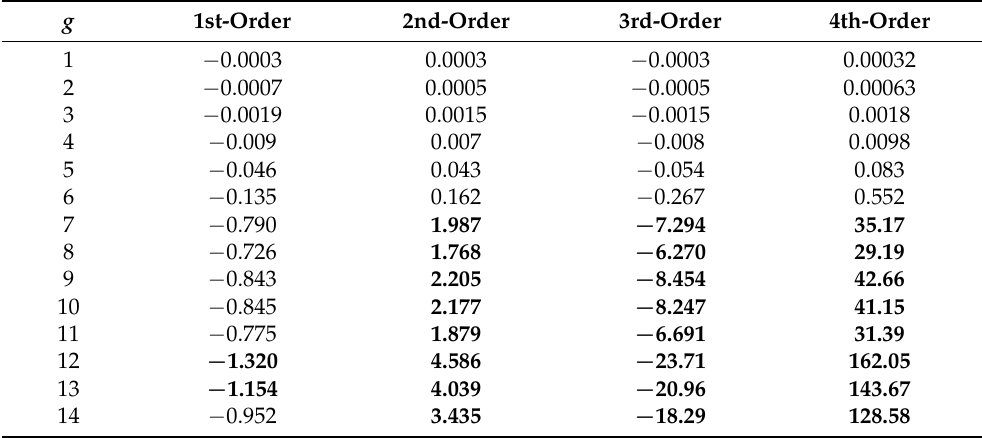
Table 2. Comparison of the 1st-order, 2nd-order, 3rd-order and 4th-order unmixed relative sensitivi- ties S ( 1 ) ( 239 Pu) of the PERP